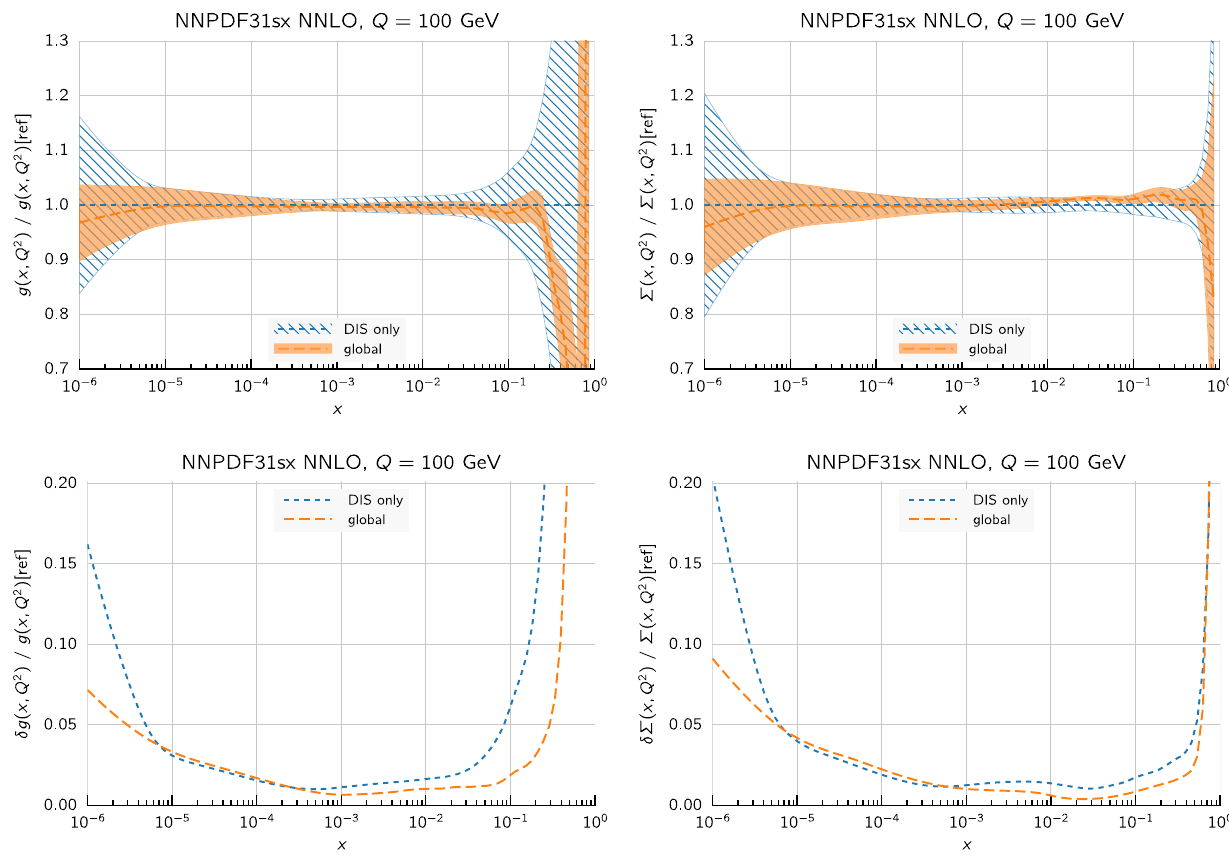
Fig. 13 Comparisonbetweenthegluon(left)andthetotalquarksinglet (right) at Q = 100 GeV between the NNPDF3.1sx NNLO DIS-only and global fits. The upper plots show the ratio of global fit results over